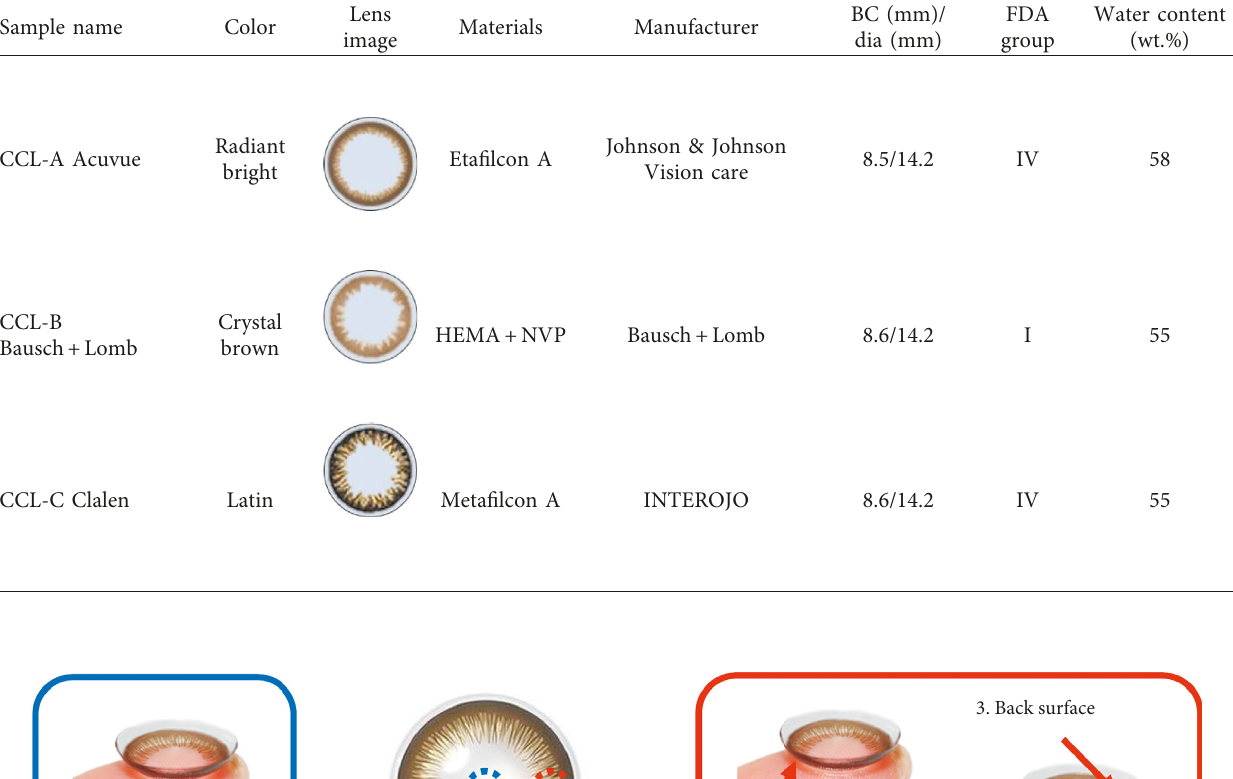
Table 1: Properties of the cosmetic contact lenses.